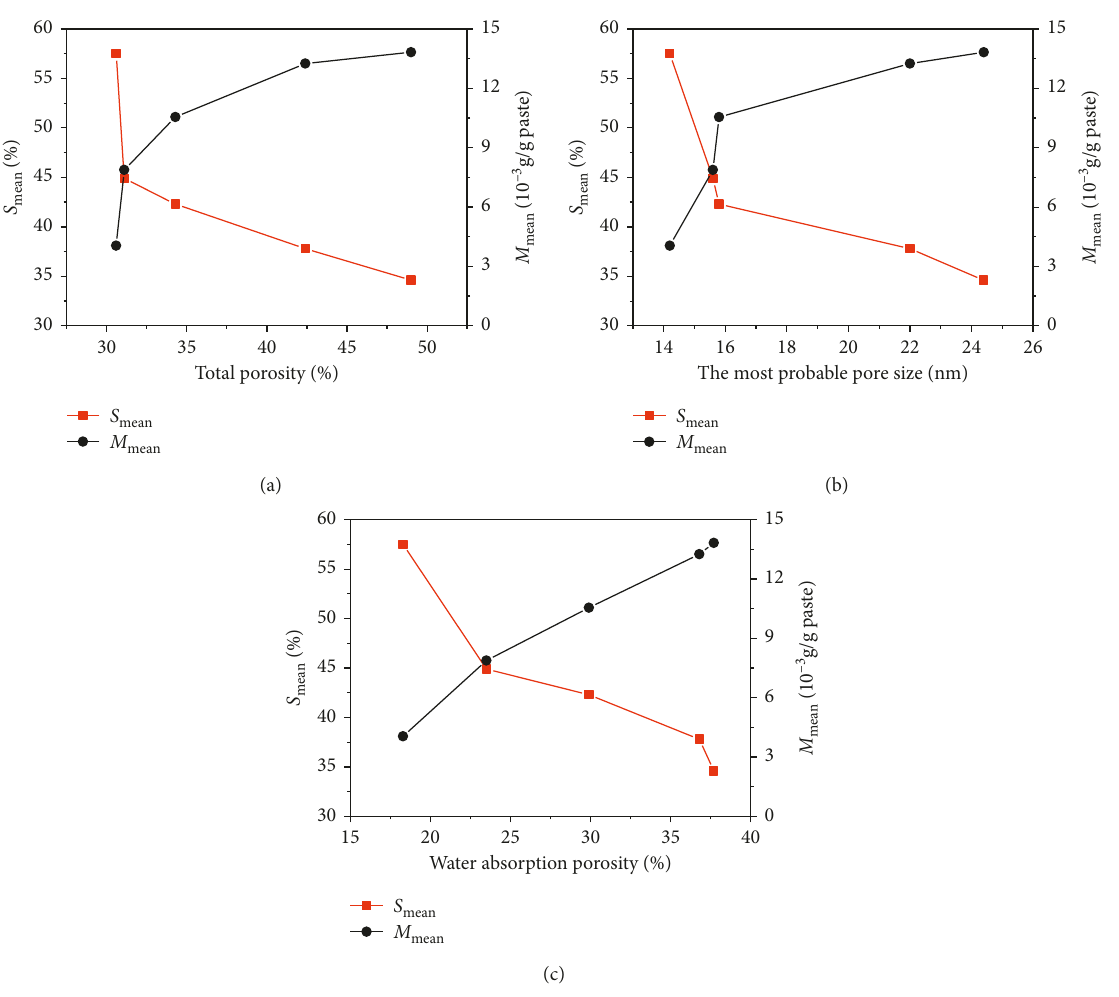
mean , M mean : (a) total porosity; (b) the most probable pore size; (c) water